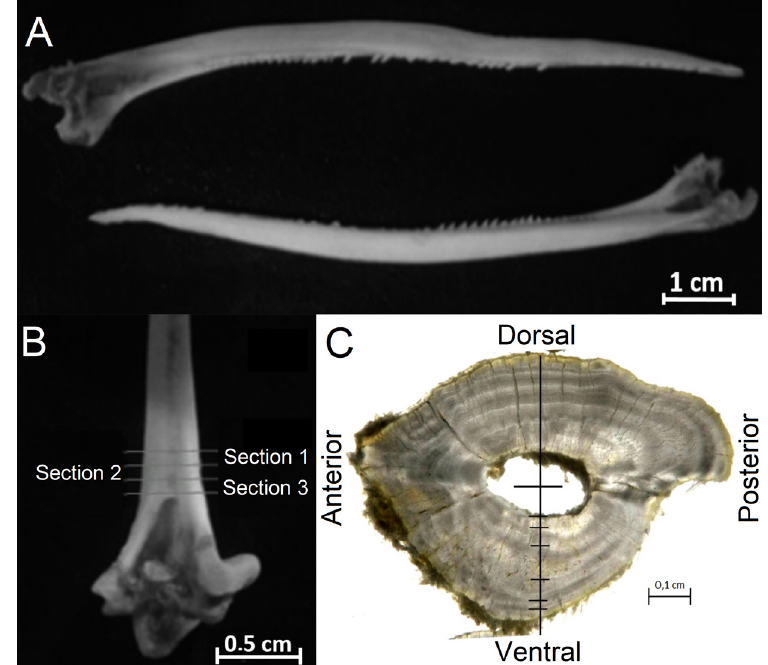
FIGURE 2 | A. Detail of a spine of Pseudoplatystoma corruscans in upper and lower views and B. detail of the proximal portion of the spine. Lines indicate the cuts positions. C. View of spine cut showing the ventral radius of the dorso-ventral axis, where distances from the estimated center of the spine foramen to the edge (Rt) and to each growth ring (Rn) were